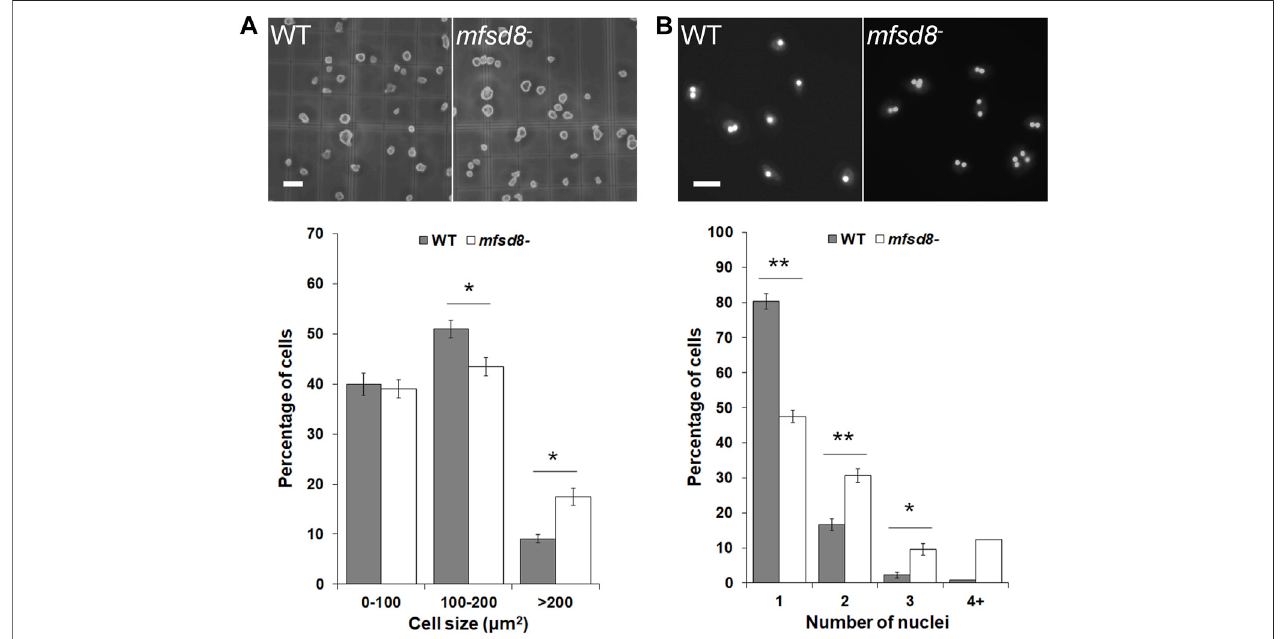
FIGURE 2 | Effect of mfsd8 -de fi ciency on cell size and cytokinesis. (A) Effect of mfsd8 -de fi ciency on cell size. WT and mfsd8 − cells grown axenically in HL5 were deposited onto a hemocytometer and imaged. Scale bar = 20 μ m. The area of each individual cell was quanti fi ed using Fiji/ImageJ. Data was placed into different cell areabinsandexpressedasameanpercentageoftotalcellsanalyzed±SEM( n =5).Statisticalsigni fi cancewasassessedusingtwo-wayANOVAfollowedbyBonferroni post-hocanalysis.* p < 0.05vs.WT. (B) Effectof mfsd8 -de fi ciencyoncytokinesis.WTand mfsd8 − cellsgrownaxenicallyinHL5werecollectedanddepositedonto coverslips placed inside separate wells of a 12-well dish. Cells on coverslips were then submerged in low- fl uorescence HL5 overnight at 21 ° C. The following day, cells were fi xed in − 80 ° Cmethanol mounted ontoslideswithProlongGold Anti-Fade Reagent containingDAPI.Scale bar =20 μ m. The number ofnuclei withineach cellwas scored.Foreachexperiment,10randomimages,eachcontainingatleast10cells,wereobtainedfromeachcoverslip.Datapresented asmeanpercentage oftotalcells analyzed ±SEM ( n = 7). Statistical signi fi cance was assessed using two-way ANOVA followed by Bonferroni post-hoc analysis. * p < 0.05 and ** p < 0.01 vs. WT.